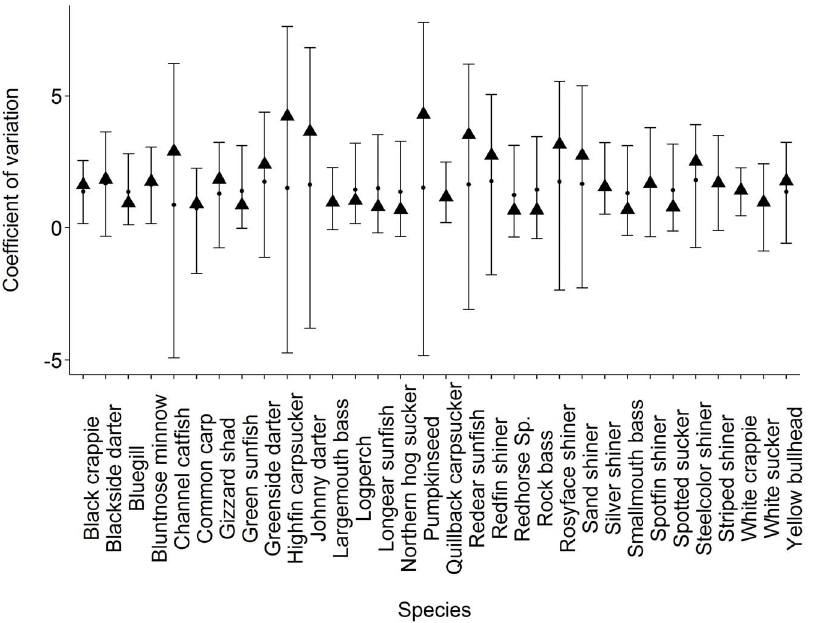
Figure 3. Results of the coefficient of variation posterior predictive check from the Bayesian hierarchical model. Points are mean estimates from the 95% credible intervals, vertical bars are the bounds of the 95% credible intervals, and solid triangles are observed mean coefficient of variation values for each species.